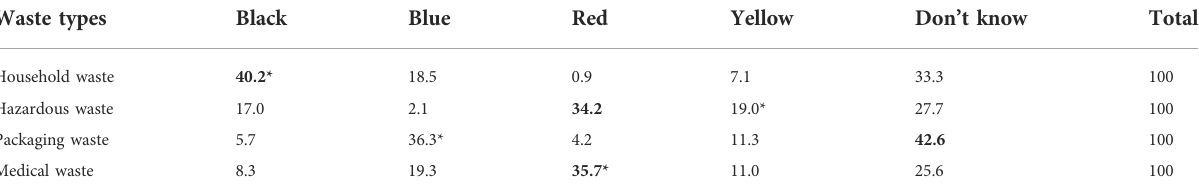
Bold values indicates the largest share.